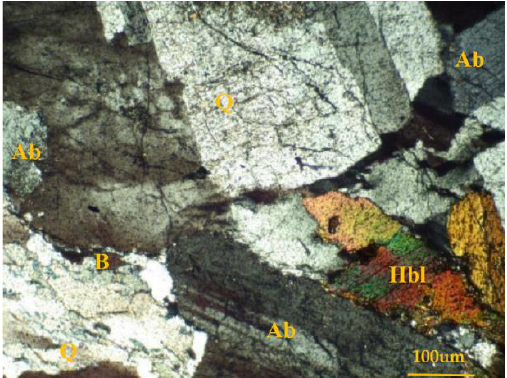
Figure 1. Micro cracks developed in the granite observed by the optical microscopy (Ab: albite, Q: quartz, Hbl: hornblende, B: biotite).